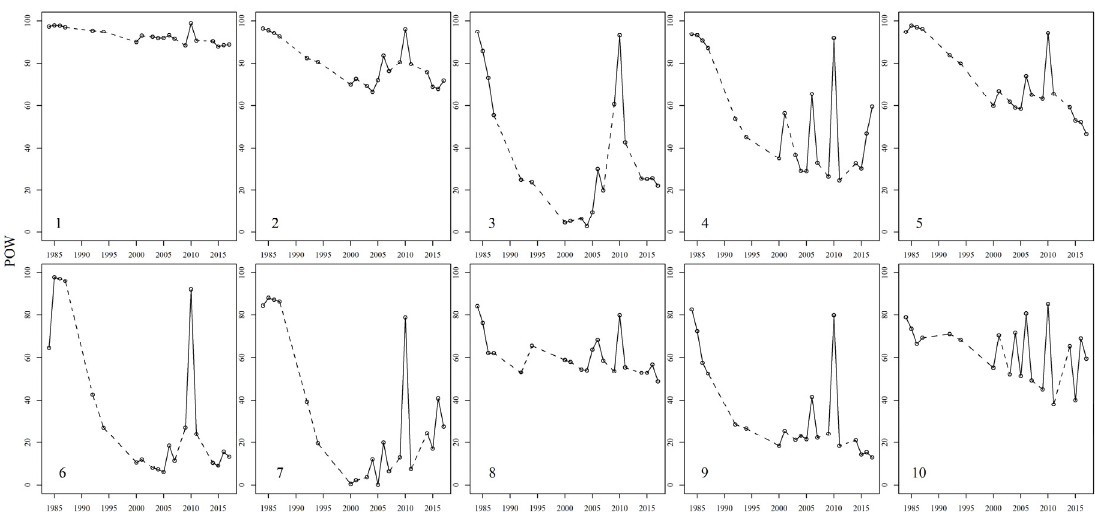
Figure 8. POW (Percentage of Open Waterbodies) values for each basin.